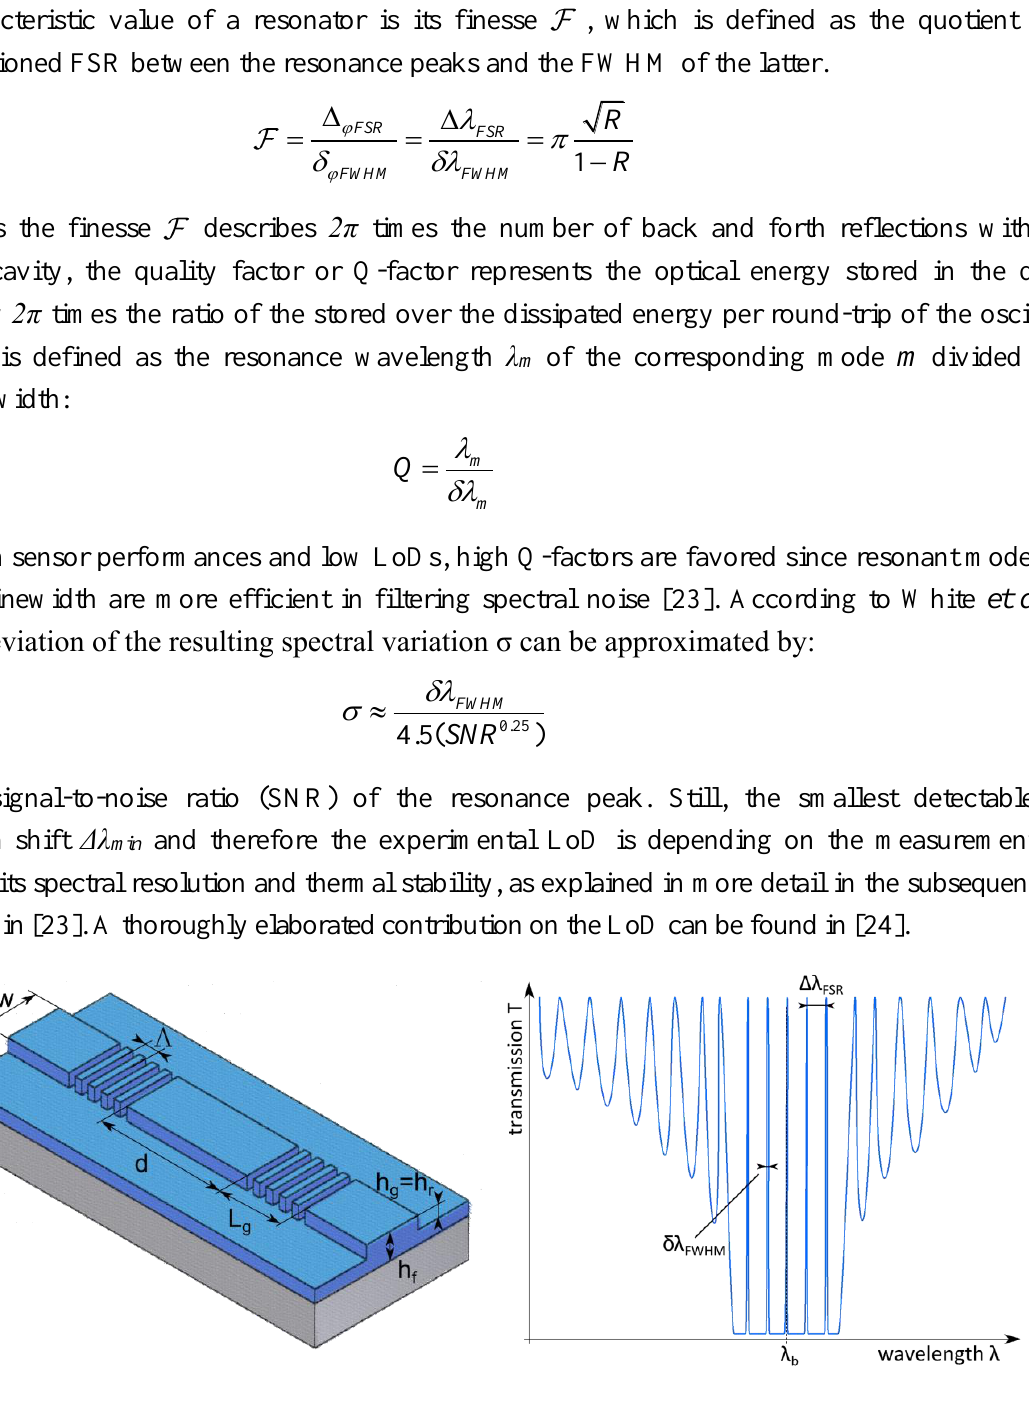
Figure 4. Schematic representation of the introduced, planar waveguide based Bragg grating resonator structure ( left ) with the resonator length d , rib width w and height h r , substrate, film and cover refractive indices n s , n f , n c , grating length L g , period Λ and depth h g , respectively. The desired transmission spectrum of the Bragg grating resonator at Bragg wavelength λ b is illustrated on the right-hand side, highlighting the free spectral range Δλ FSR and full width at half maximum (FWHM) δλ FWHM